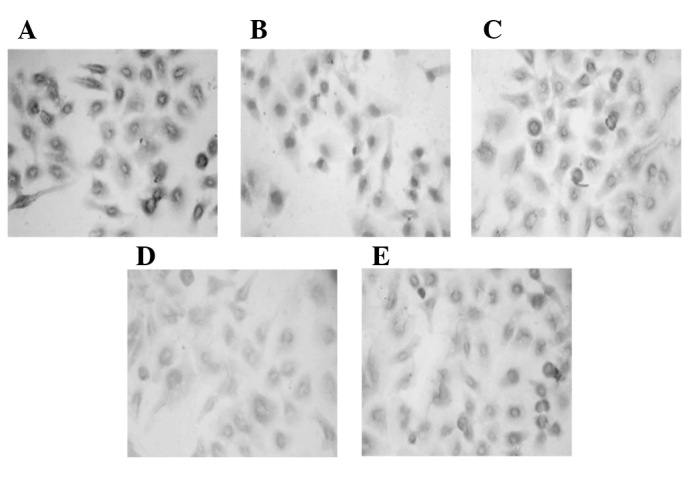
Immunohistochemical detection of synuclein-γ (SNCG) expression in breast cancer MCF-7 cells transfected with SNCG-siRNA. (A) Empty vector control; (B) SNCG-siRNA-1; (C) SNCG-siRNA-2; (D) SNCG-siRNA-3); (E) SNCG-siRNA-4. Streptavidin-peroxidase (SP), ×200.